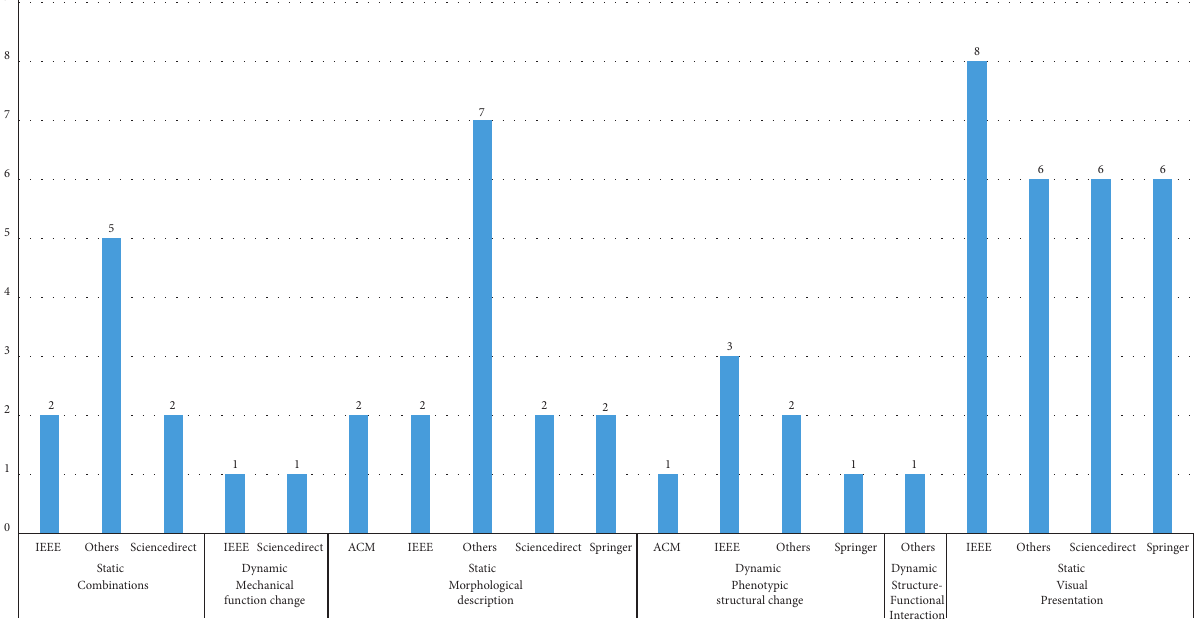
Figure 9: Classification by number of papers published by publishers and visualization